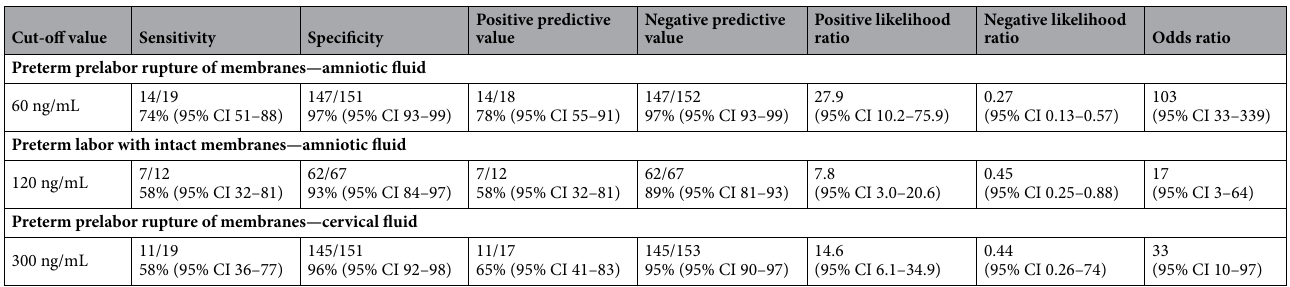
Table 5. The predictive values of cut-off values of amniotic fluid IgGFcBP to identify intra-amniotic infection. CI: confidence interval.